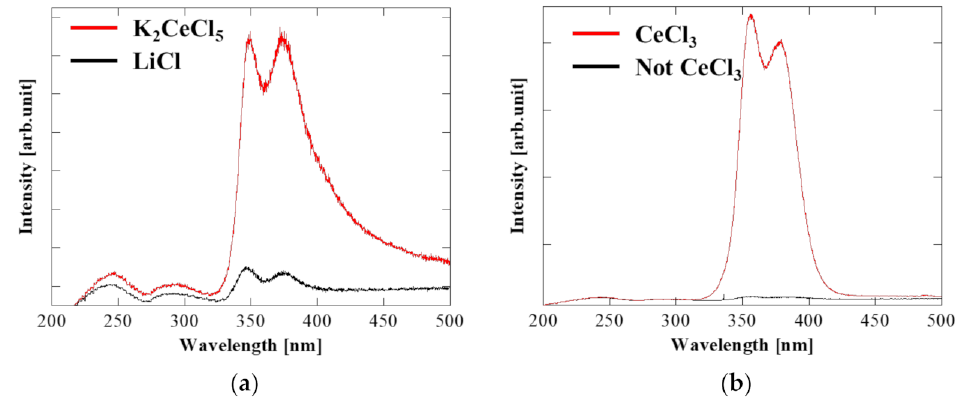
Figure 6. The CL spectra of prepared ( a ) K 2 CeCl 5 /LiCl and ( b ) CeCl 3 /SrCl 2 /LiCl.